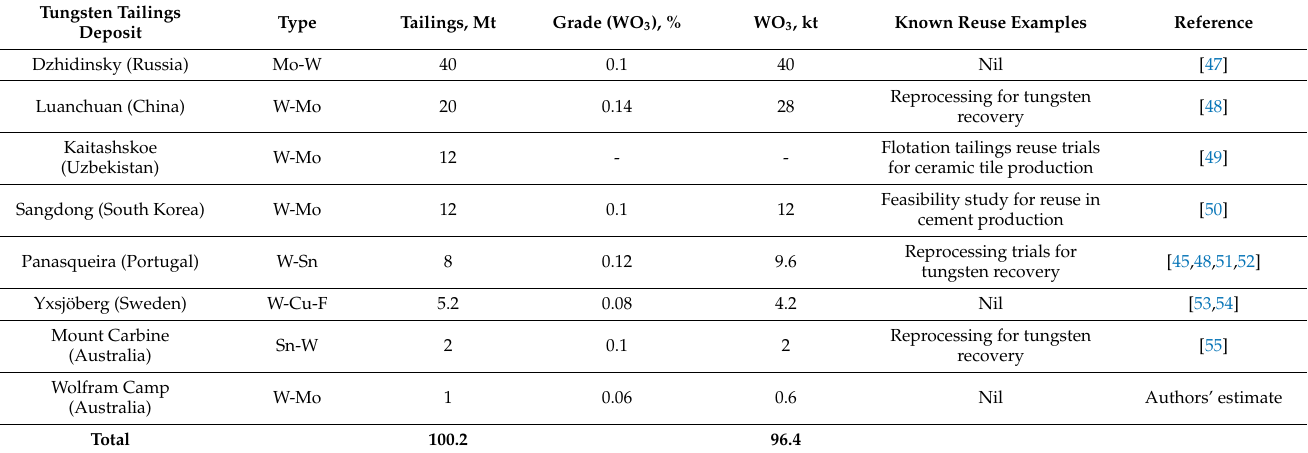
Table 4. Worldwide tungsten tailings deposits and known reuse